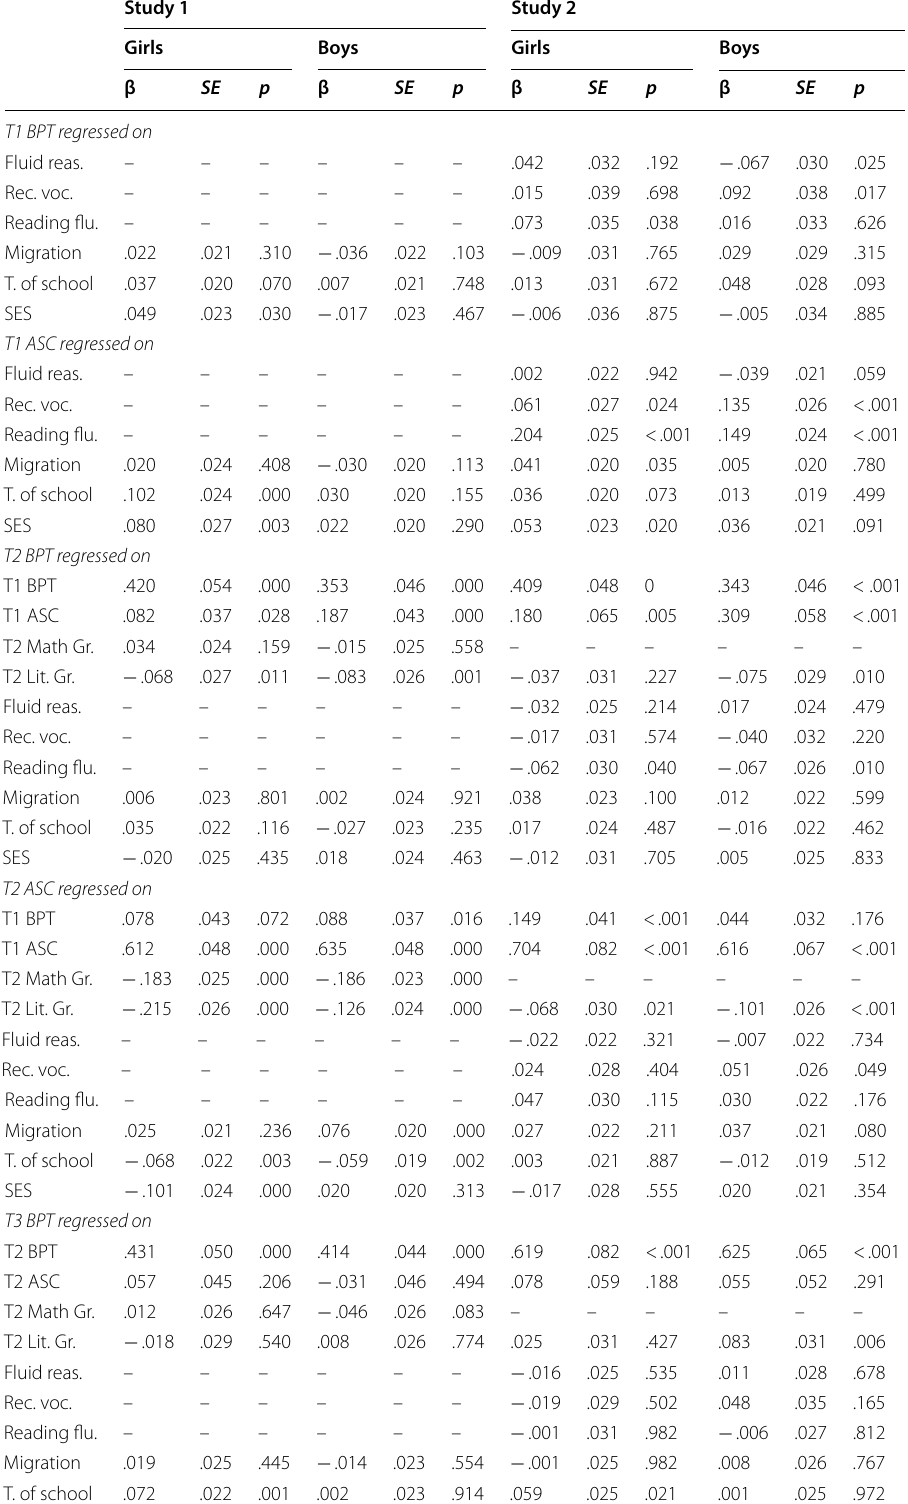
Table 2 Study 1 and Study 2: relations between academic self-concept and belief about one’s own perspective-taking over time Study 1 Study 2